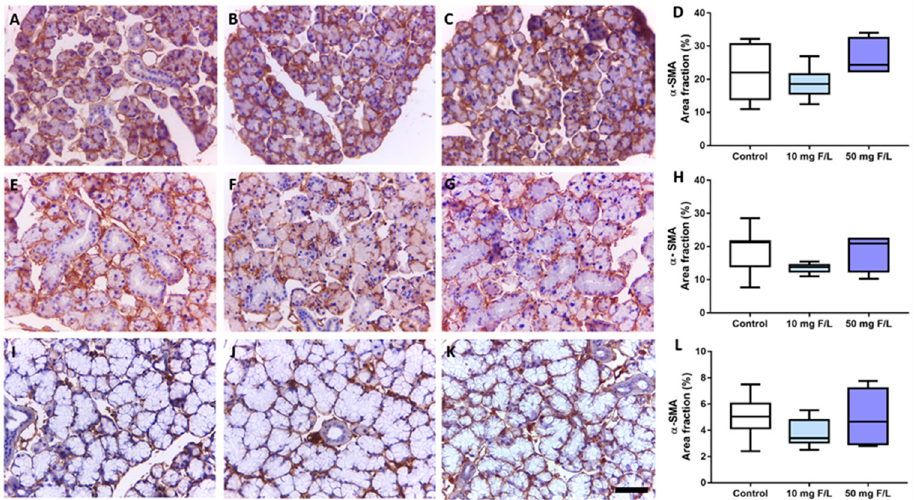
Figure 4. Effects of 60 days exposure to 0, 10, or 50 mg F/L on smooth muscle actin immunostaining area fraction in mice salivary glands, represented by photomicrographs of each group and graphs of the area fraction analysis. Letters ( A – D ) represent the parotid gland; ( E – H ), the submandibular gland; ( I – L ), the sublingual gland. From left to right (columns), control, 10 mg F/L, and 50 mg F/L groups, and area fraction graphs. Brown areas indicate positive labeling for the antibody by DAB reaction, while blue areas are counterstained by Harris’ hematoxylin. Results are expressed as median and interquartile range. Different superscript letters indicate a statistical difference between the groups. The absence of letters indicates that there was no statistical difference. Kruskal–Wallis test, followed by Tukey’s post hoc test, p < 0.05. 50 µm scale bar. ( n = 8 animals/group).